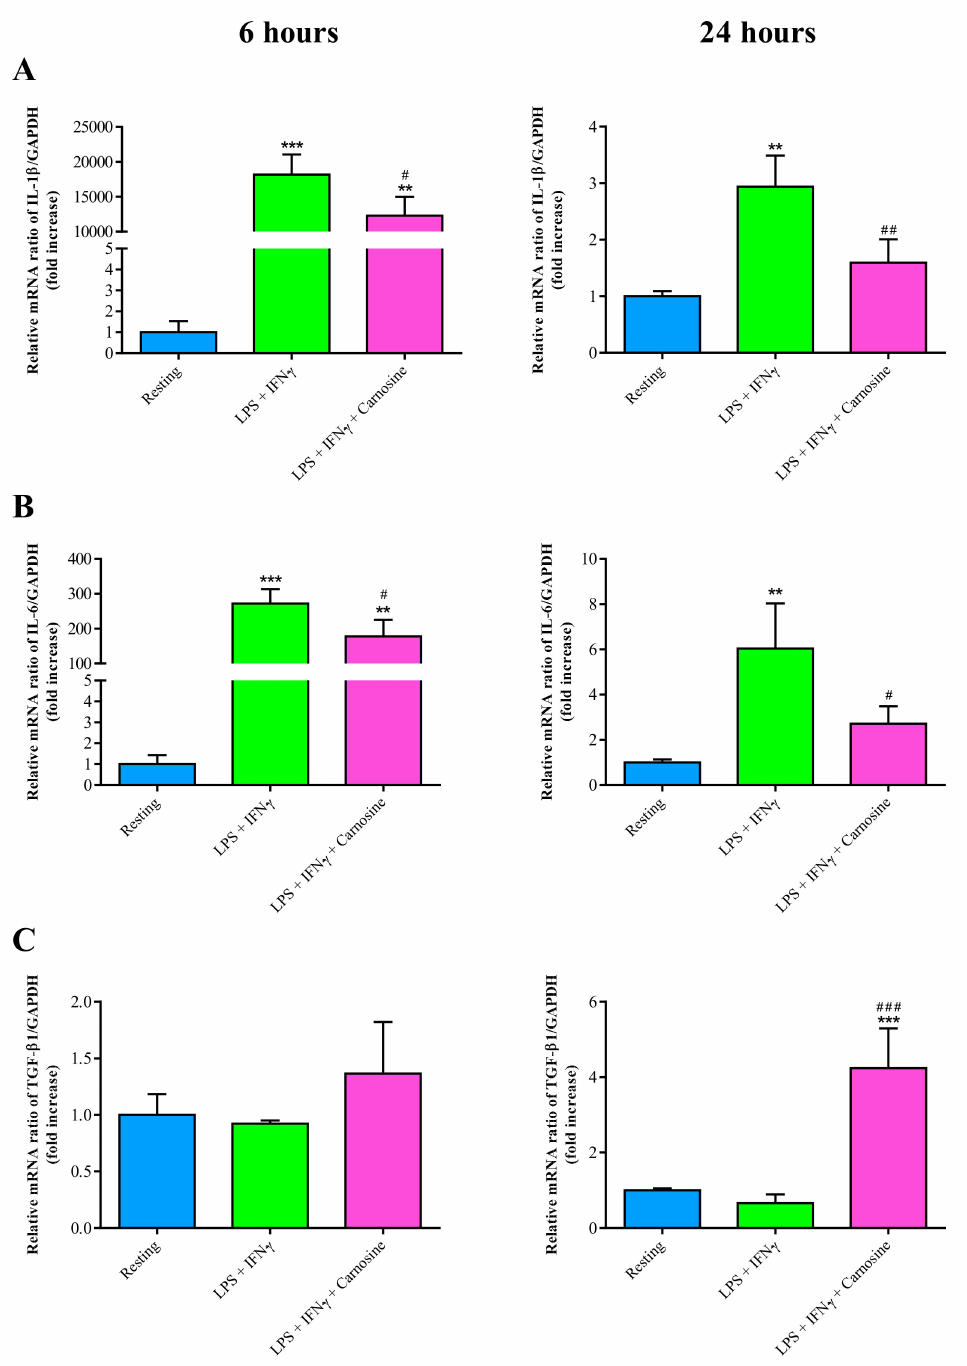
Figure 7. Gene expressions of IL-1 β ( A ), IL-6 ( B ), and TGF- β 1 ( C ) in resting (control) RAW 264.7 macrophages and in macrophages stimulated with LPS (100 ng / mL) + IFN- γ (600 U / mL), in the absence or in the presence of carnosine (20 mM), at 6 h and 24 h. The abundance of each mRNA was expressed relative to the abundance of GAPDH-mRNA. Values are means ± SD of three to four independent experiments. ** p < 0.01 vs. resting; *** p < 0.001 vs. resting; # p < 0.05 vs. LPS + IFN- γ ; ## p < 0.01 vs. LPS + IFN- γ ; ### p < 0.001 vs. LPS + IFN- γ